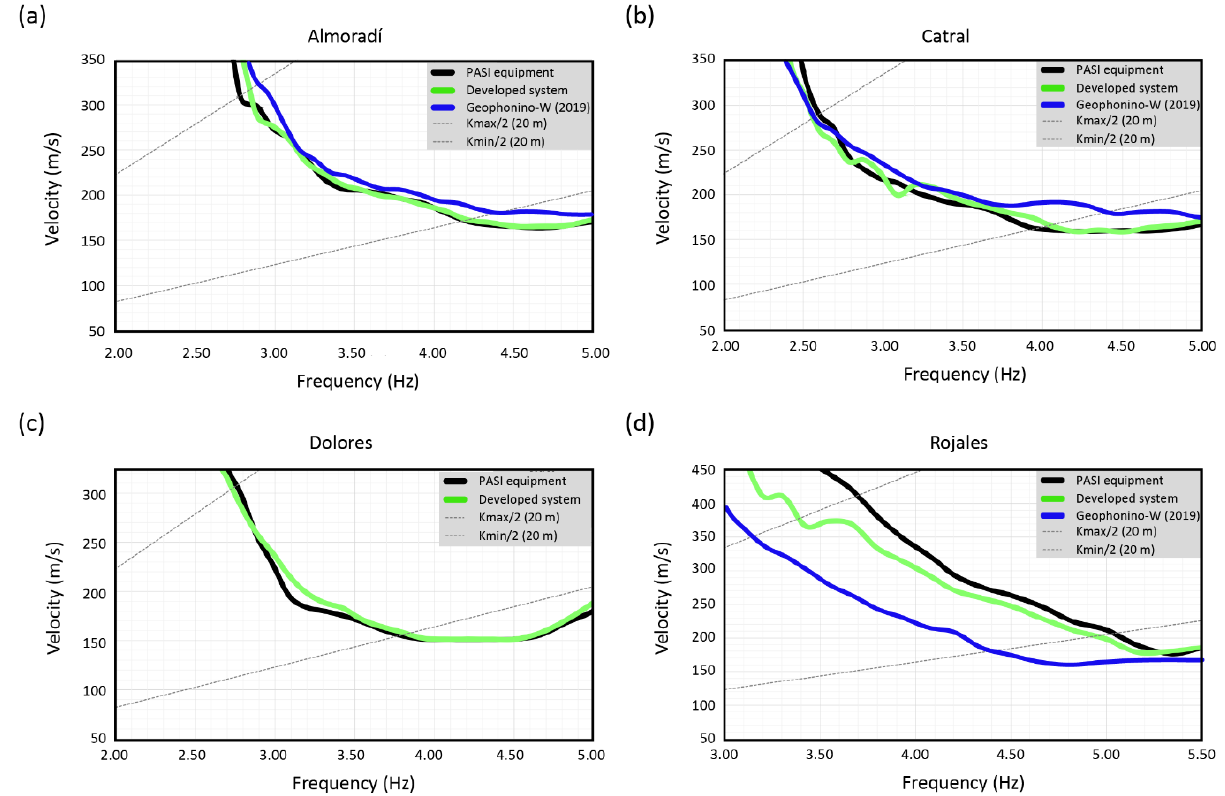
Figure 13. Dispersion curves estimated with the developed data acquisition system (green color), Geophonino-W [33] (blue line), and the commercial equipment (black color) for the sites under study: ( a ) Almoradí, ( b ) Catral, ( c ) Dolores, and ( d ) Rojales. Wavenumber limits (k max /2 and k min /2) are represented with dashed lines.